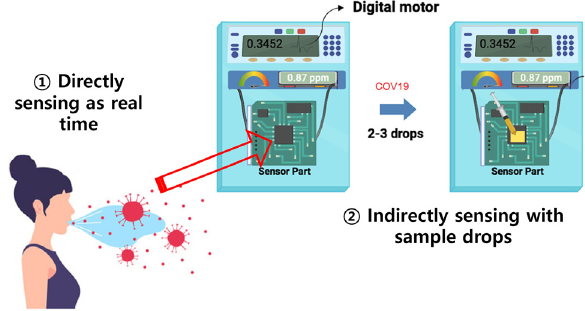
Figure 6: Graphene - based COVID - 19 proposed sensor; the sensor system is working as real time in droplet transmission conditions or with sample drops obtained from